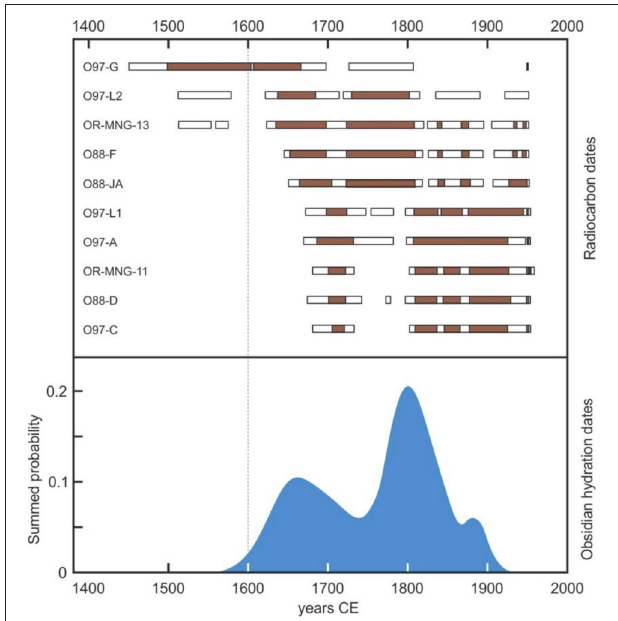
FIGURE 5 | Summary of all reliable radiocarbon and obsydian hydration dates obtained in Orongo. Redrawn from Robinson and Stevenson (2017), after original data from Orliac and Orliac (1996) and Stevenson et al. (2013). Radiocarbon dates are expressed as 1 α (brown bars) and 2 α (white bars)